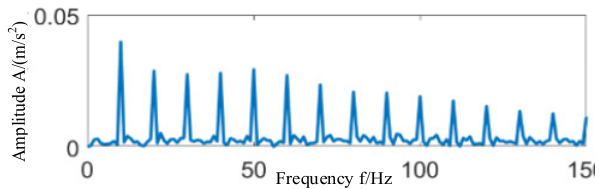
Figure 13. The envelope spectrum of the reconstructed signal.